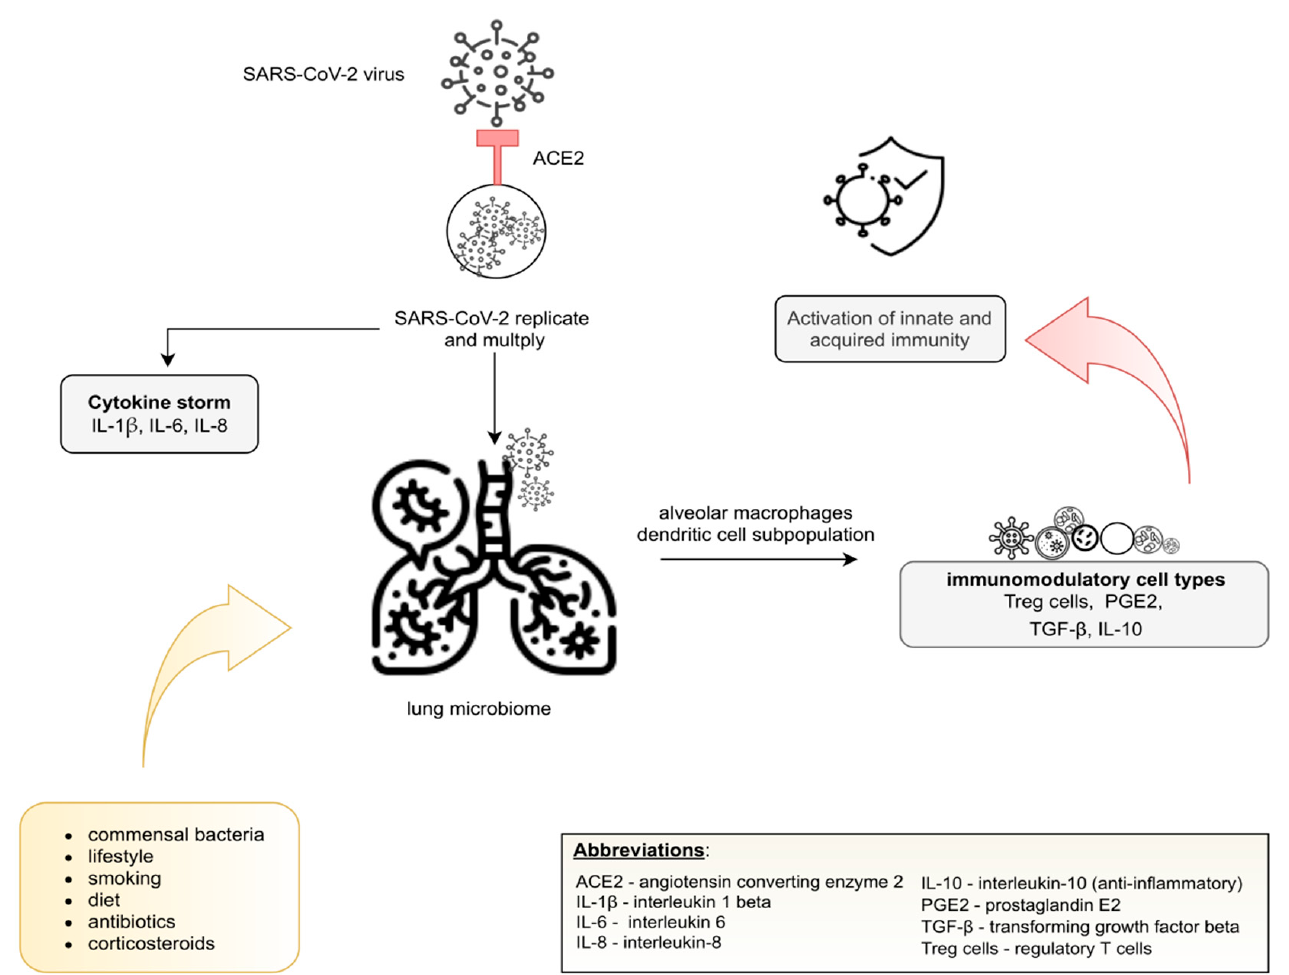
Figure 2. The lung microbiome after SARS-CoV-2 infection.